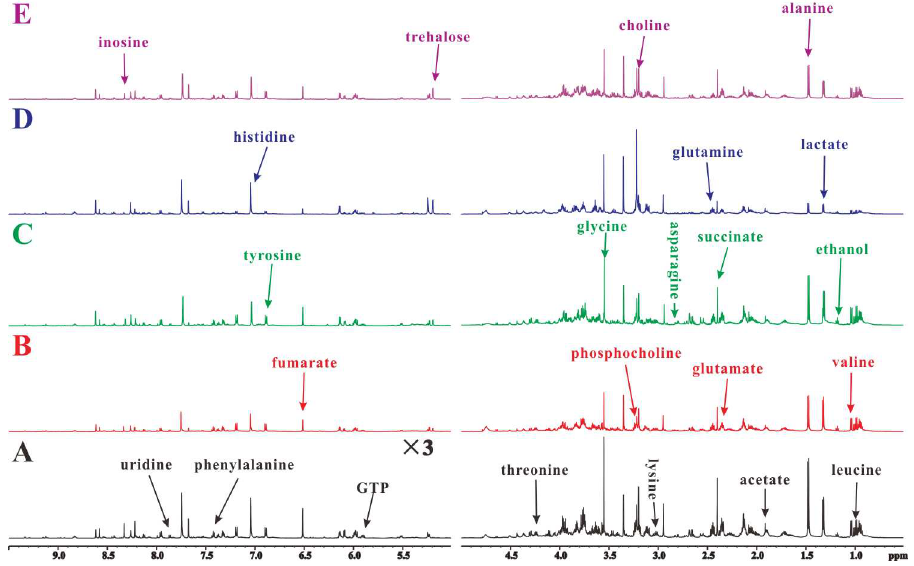
Fig 2. Representative 1 H NMR spectra of midgut extracts obtainedfrom a water-fed Eri silkworm(A), a 0.25% DNJ-fed Eri silkworm (B), a 0.5% DNJ-fed Eri silkworm (C), a latex-fed Eri silkworm (D), and a mixture- fed Eri